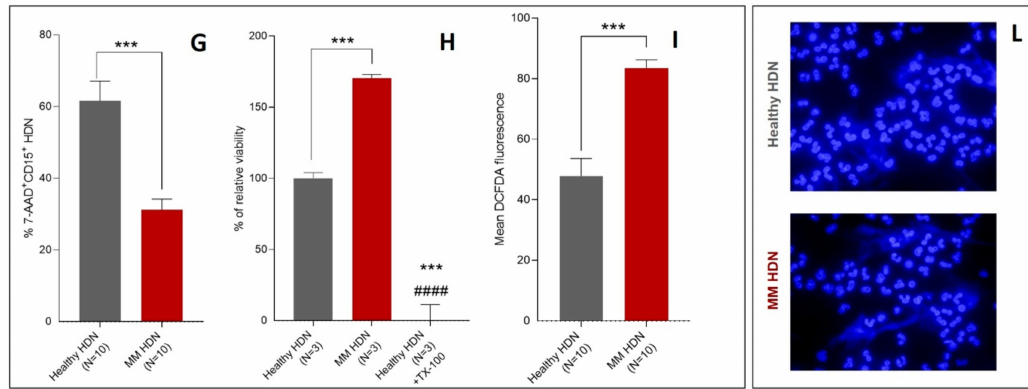
Figure 2. High-density neutrophils of MM patients have distinct phenotypes. Cells were isolated using a density gradient as described in the methods section, and the proportion of LOX-1 + cells was calculated among CD15 + cells by flow cytometry. ( A ) Example of staining with CD15 and LOX-1 antibodies to detect low-density neutrophils (LDN) and ( B ) high-density neutrophils (HDNs) in healthy and MM patients, according to Condamine et al. [17]. ( C ) Proportion of LOX-1 positive LDN and ( D ) LOX-1 positive HDN in peripheral blood of 10 healthy and 10 newly diagnosed MM patients. Individual results for each patient are shown as well as mean and standard deviations. p values ( t -test) are shown. E – G HDNs were isolated from healthy and MM patients using a density gradient as described in Methods and maintained in culture with 10% FBS complete RPMI media for 96 h. ( E ) Example of time-course (24, 48, 72, and 96 h) of HDN viability as detected by 7-AAD / Annexin V assay in a healthy (top row) and a MM subject (bottom row). ( F ) Changes in the time-course of cell viability for HDN obtained from healthy (grey line) and MM subjects (red line), cultured up to 96 h in 5% CO 2 , 37 ◦ C in complete RPMI medium and + 10% FBS. Cell viability was assayed by 7-AAD / Annexin V at each time point indicated. Represented values are mean and standard deviations of five independent experiments using HDNs obtained from 10 healthy and 10 MM subjects. ( G ) Percentage of 7AAD + cells described in F was evaluated at 96 h, showing longer survival in vitro for MM-HDN but not for healthy ones. ( H ) Lactate dehydrogenase (LDH) viability assay on HDNs cultures exposed to increasing concentrations of purmorphamine and cyclopamine (0.01–10 µ M). Data are shown as dot plots, and viability is calculated as the percentage of controls assumed as 0%. ( I ) Flow cytometry analysis of intracellular reactive oxygen species (ROS) generation, detected by flow cytometry using Dichlorodihydrofluorescein diacetate (DCFH-DA). ( L ) DAPI staining of DNA revealed the presence of neutrophil extracellular traps